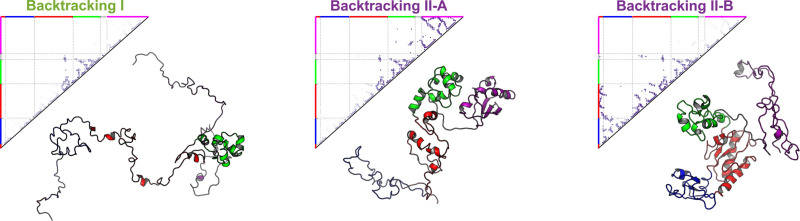
Native contact maps and structures of DPO4 at backtracking.All-atom representations of DPO4 reconstructed based on the Cα structures from the simulations (Rotkiewicz and Skolnick, 2008).